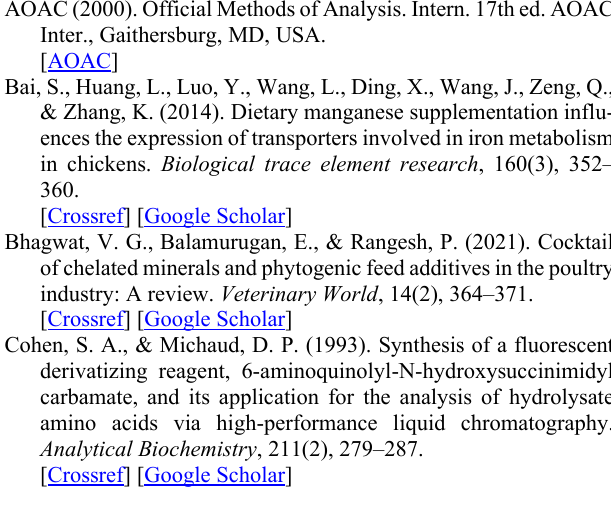
Comparative assessment of the total value of the protein of broiler muscle tissue, % (n = 5) Depending on natural moisture, % The experimental group (suppled with chelated The control group (supplied with sulfates of Amino acids compounds of Zn, Cu, and Mn) Zn, Cu, and Mn) red muscles white muscles red muscles white muscles Triptophane